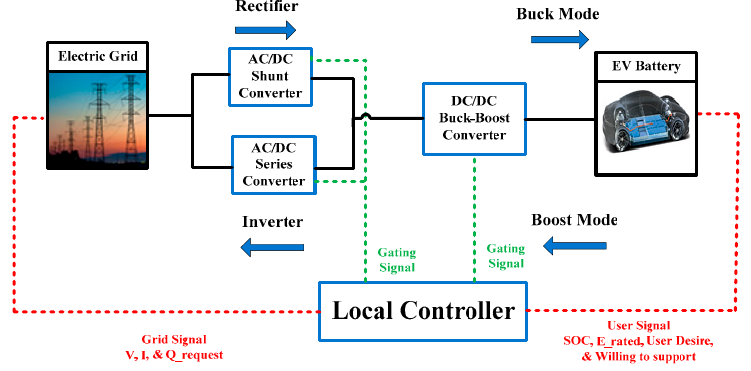
Figure 2. Proposed system control block diagram.